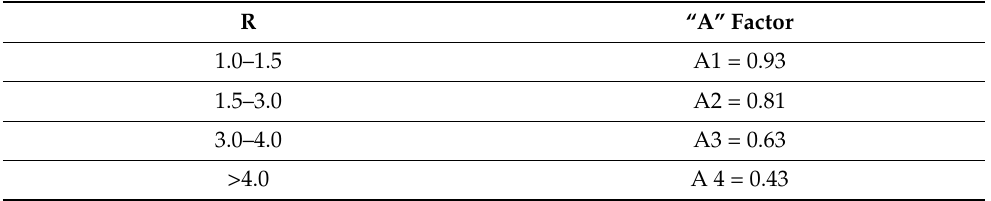
Table 2. “A” factor decreases when “R” ratio increases.